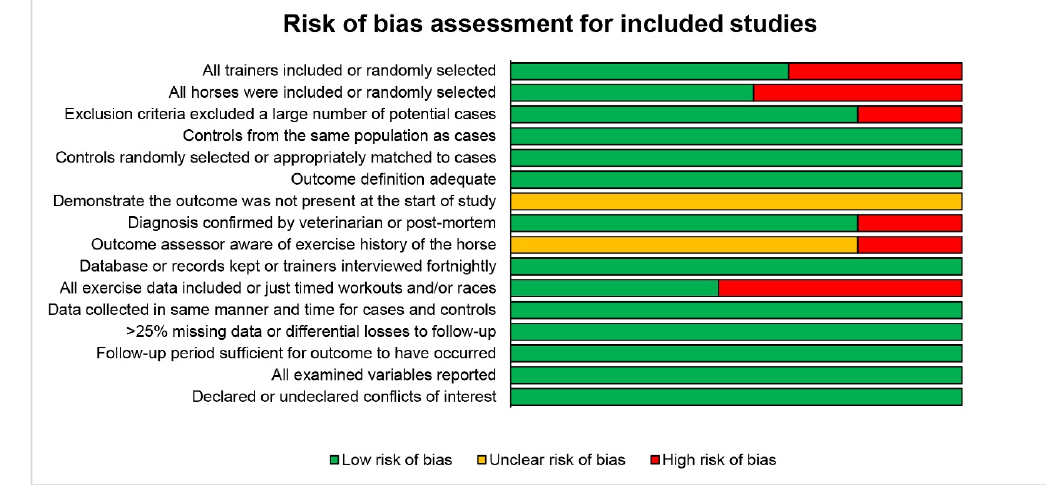
Figure 3. The risk of bias assessment for included studies.